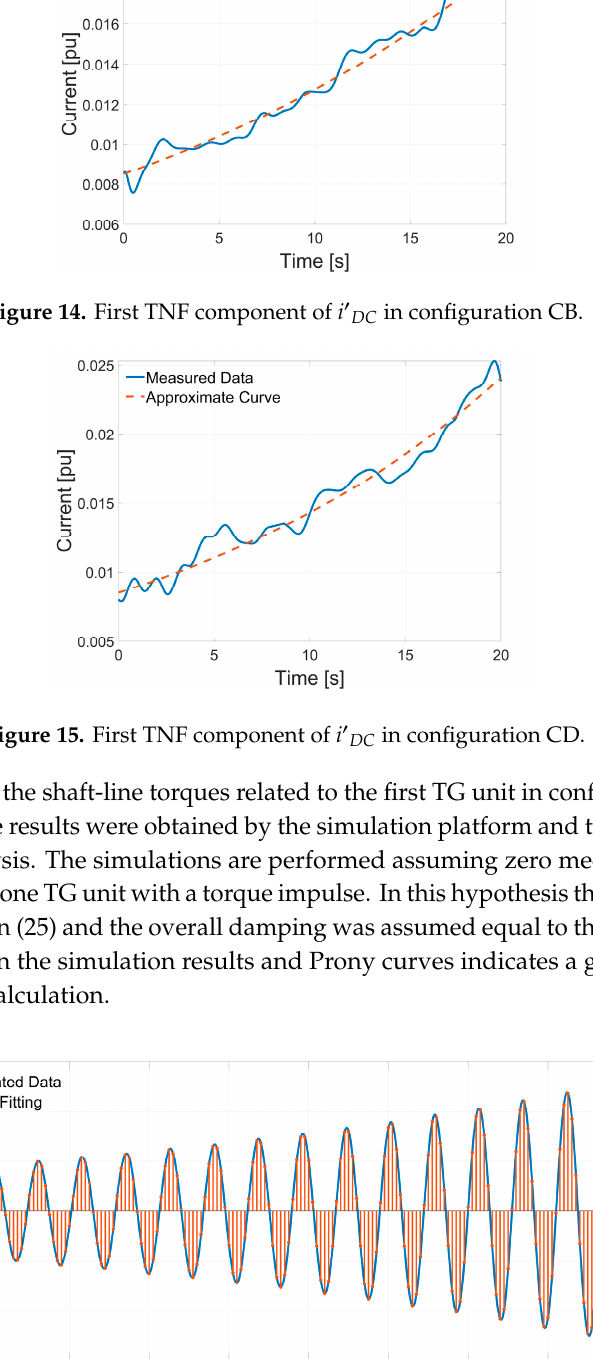
Figure 16. TG shaft-line torque in configuration CA (simulation results).